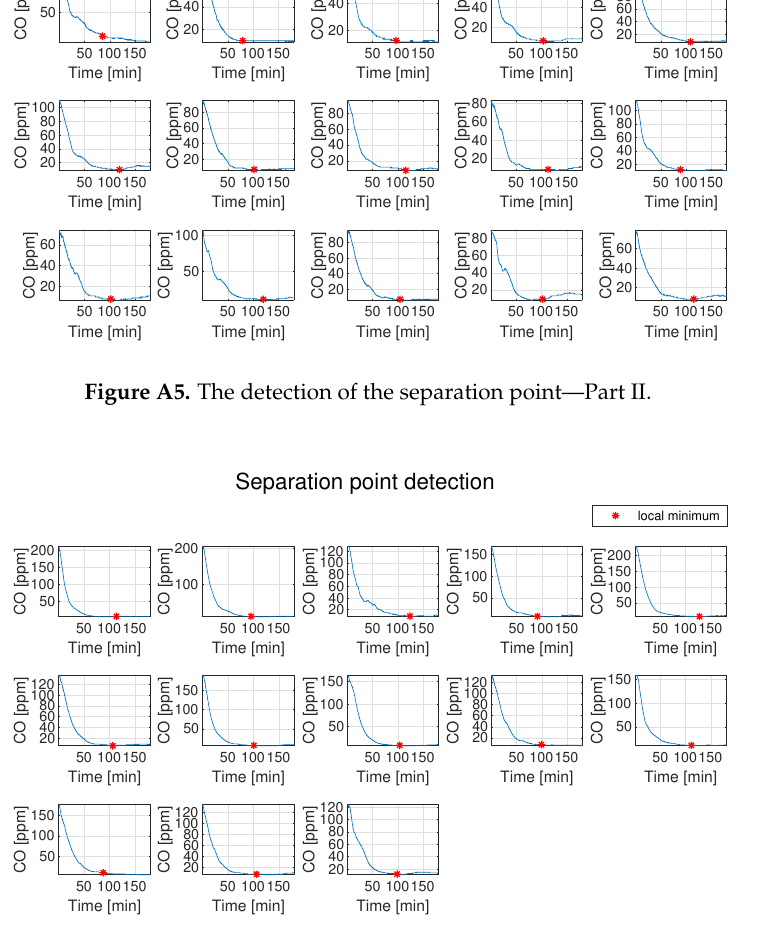
Figure A6. The detection of the separation point—Part